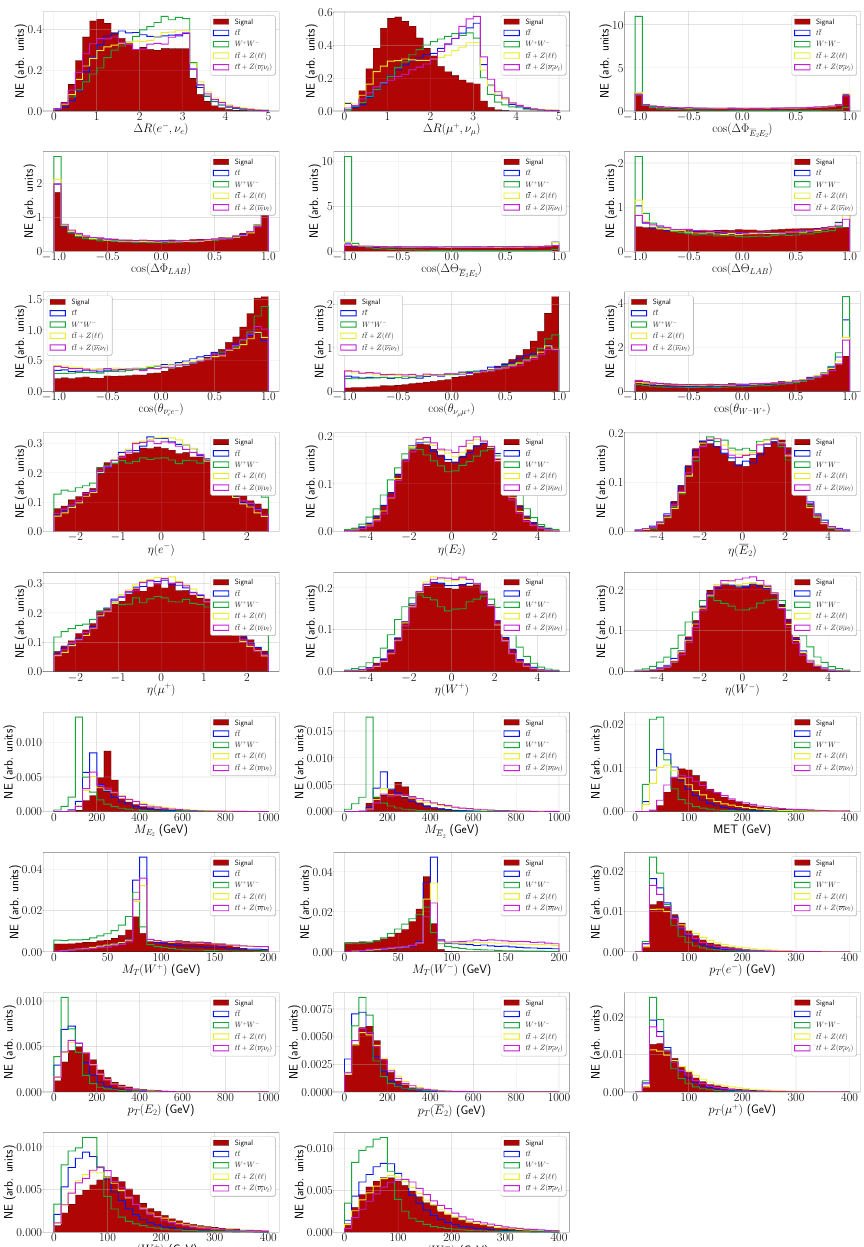
Figure 12. Set of angular and kinematic observables for VLL pair-production via the ZA topology with a mass m E = 200 GeV. All histograms are normalized, with each having 30 bins. Signal 2 distributions are filled and shown in red, while background distributions are unfilled and shown in blue ( t ¯ t − ), green ( W + W − ), yellow ( t ¯ t + Z ( ‘‘ ) ) and pink ( t ¯ t + Z (¯ ν ‘ ν ‘ ) ). From top-left to bottom-right, we have ∆ R distributions for final states combinations ( e − , ν ) and ( µ + , ν ) ; distributions for cosine of angle ∆Φ and ∆Θ in the laboratory and E 2 ¯ E 2 centre-of-mass frames; distributions of the cosine of the angle between the pairs of particles ( ν, e − ) , ν, µ + and W + W − ; pseudo-rapidity for the particles ¯ E ¯ E e − , E µ + , W + and W − ; mass distributions for E 2 , 2 , 2 and 2 ; MET; transverse mass distributions for W + and W − and transverse momentum distributions for e − , E 2 , ¯ E 2 , µ + , W + and W −